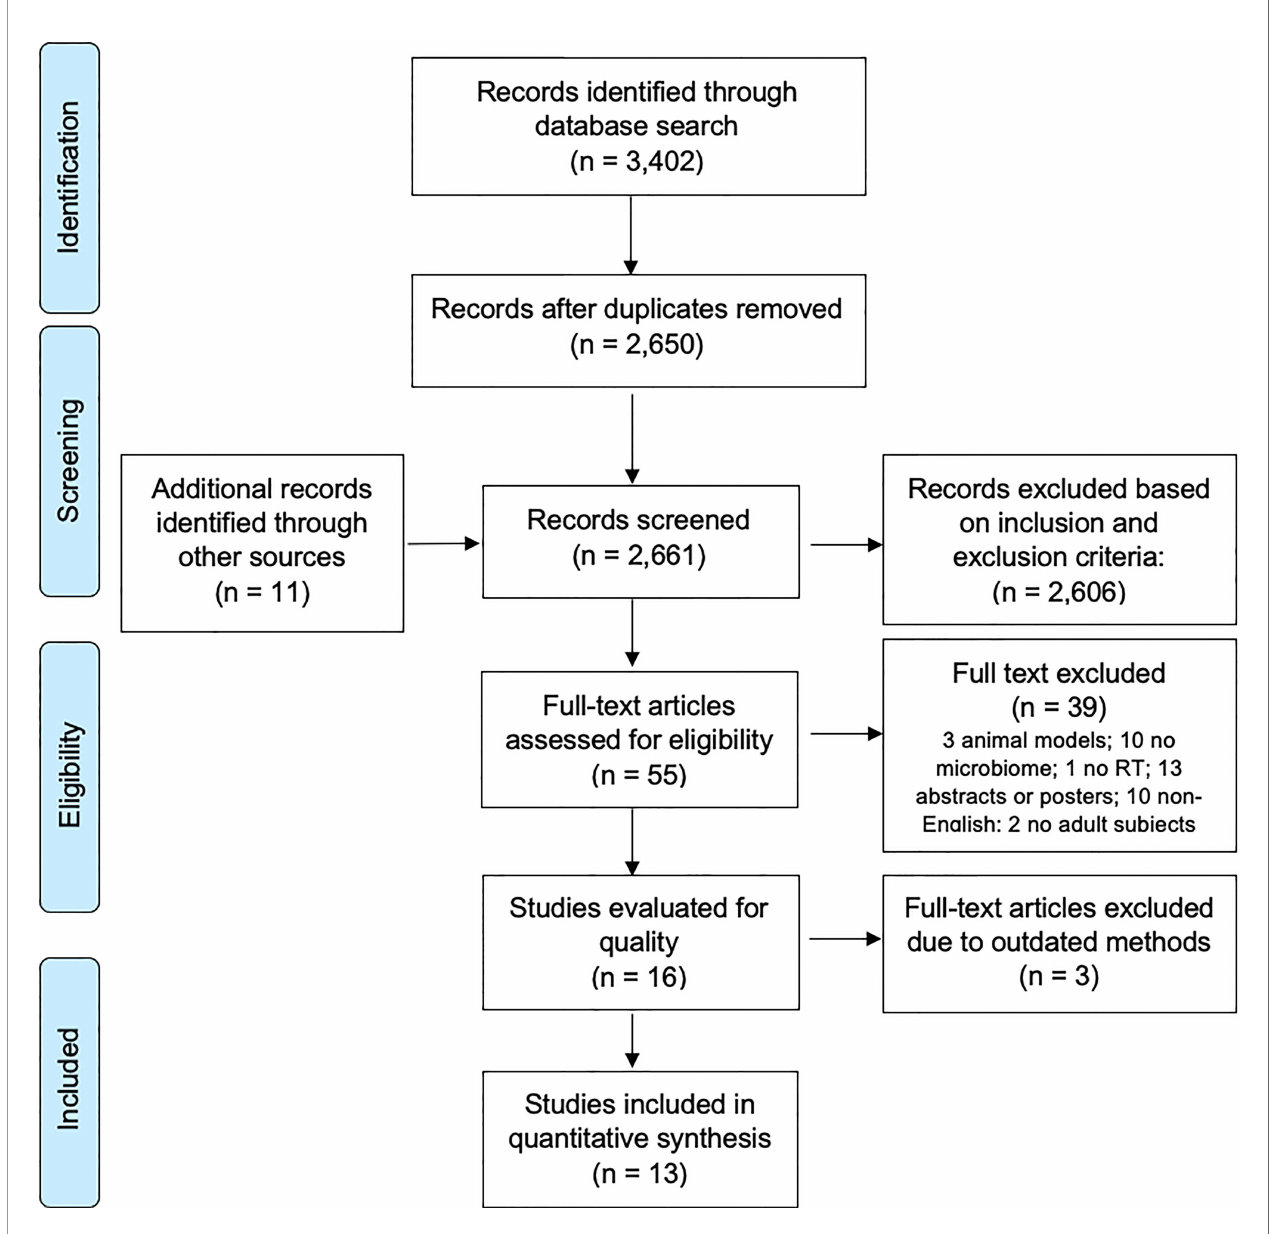
FIGURE 1 | PRISMA fl ow diagram of the studies of the gut microbiome and RT-related gastrointestinal